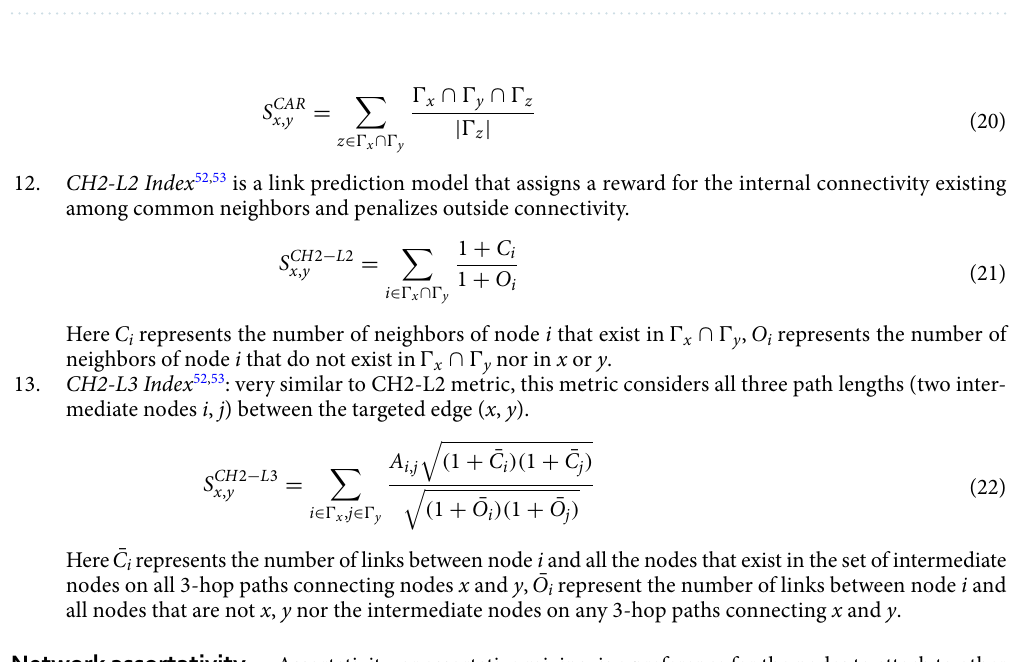
Figure 1. Level of assortativity for two networks. High-degree nodes are colored dark green while low-degree nodes are colored with a lighter color. Each node is labeled with its degree. ( a ) Assortative networks ( r = 0.6 ) where high-degree nodes are attached to high-degree nodes and low-degree nodes are attached to low-degree nodes. ( b ) Disassortative networks ( r = − 0.84 ) where high-degree nodes are attached to low-degree